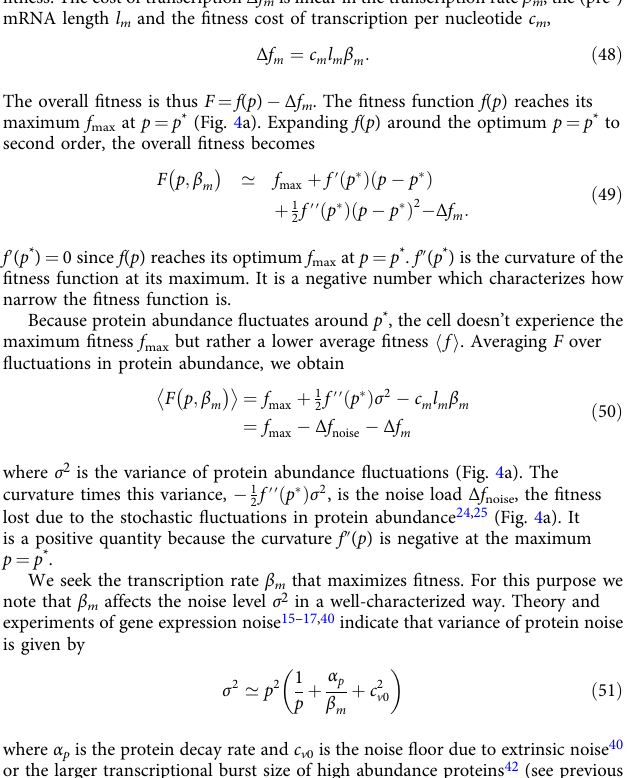
β m β p where we have used p (cid:2) ¼ α m α p . Note that we introduced two new variables C and Q . ð 53 Þ represents the fi tness cost of transcription per mRNA molecule for a gene with pre- mRNA length l m . ð 54 Þ is the gene ’ s sensitivity to noise. Genes with narrower fi tness functions f ′′ p (cid:2) ð Þ (cid:6) 0 ð Þ are more noise sensitive. A gene ’ s sensitivity to noise also depends on p * because stochastic fl uctuations σ 2 scale with p * (Eq. (51)). From the expression for the optimal β p / β m (Eq. (52)), we see that genes dominated by comparable requirements of precision and economy are predicted to share the same translation/transcription ratio. Genes with narrow fi tness function require more precision and thus have lower translation/transcription ratios (Fig. 4b). Higher transcription cost per mRNA molecule — due to longer mRNAs l m or rapid mRNA turn-over α m or a scarcity of nucleotides leading to increased cost c m — shifts the balance towards higher ratios. Note that the translation/transcription ratio does not depend on translation cost, although this cost is typically larger than transcriptional cost 18,20,21 . This is because we assumed that, for a given protein abundance, translation cost are the same if the proteins are synthesized from few or many mRNAs. Predicting the boundary of the depleted region of Crick space . In this section, we ask what is the predicted offset of the line that forms the boundary of the depleted region, namely the constant k such that β p / β m > k for all genes. We provide estimates based on known fundamental parameters of cell biology sug- gested by the